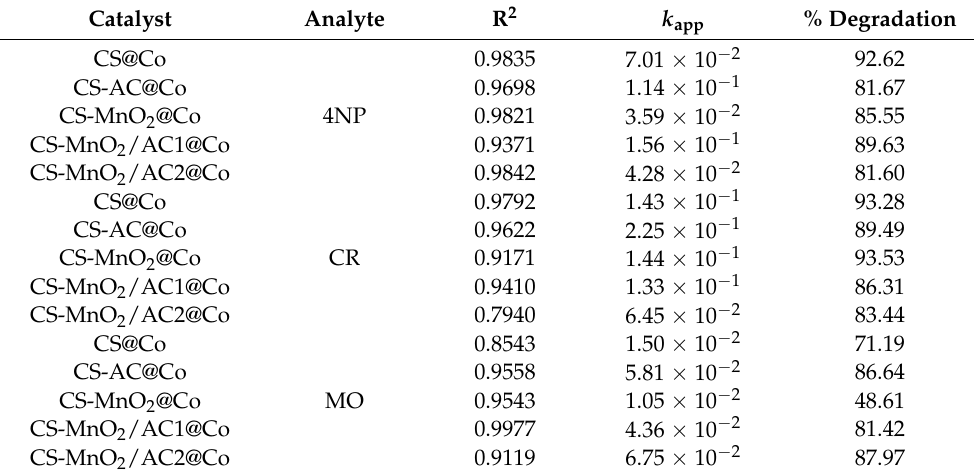
Table 1. Rate constant, R 2 values and % reduction or degradation values of 4NP and MO and CR dyes by using Co NPs supported on different polymer